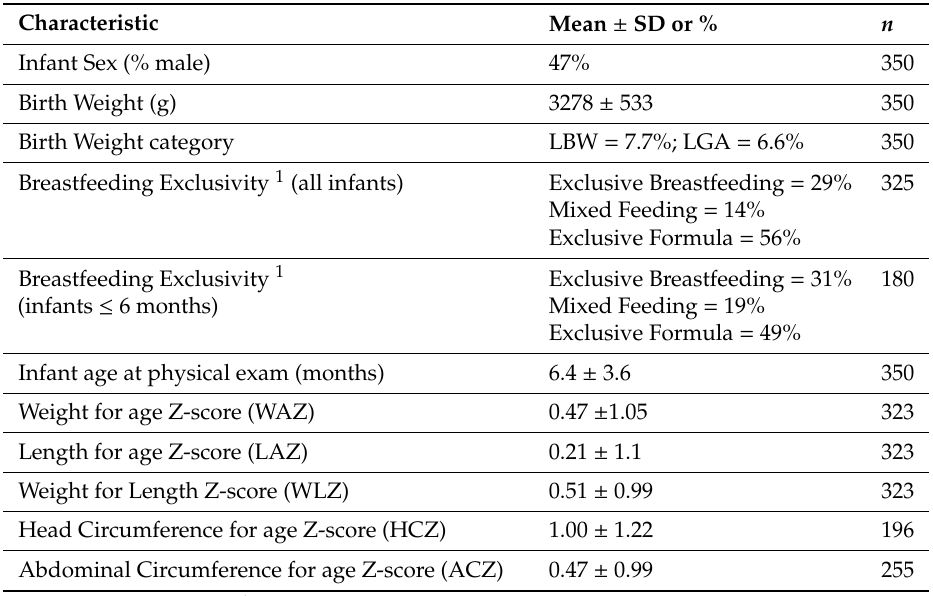
Figure 1. Sample sizes for generation of the final dataset of infants ≤ 12 months of age from the NHANES 2015–2016 dataset. Cohort characteristics are presented in Table 1. Table 1. Cohort Characteristics.